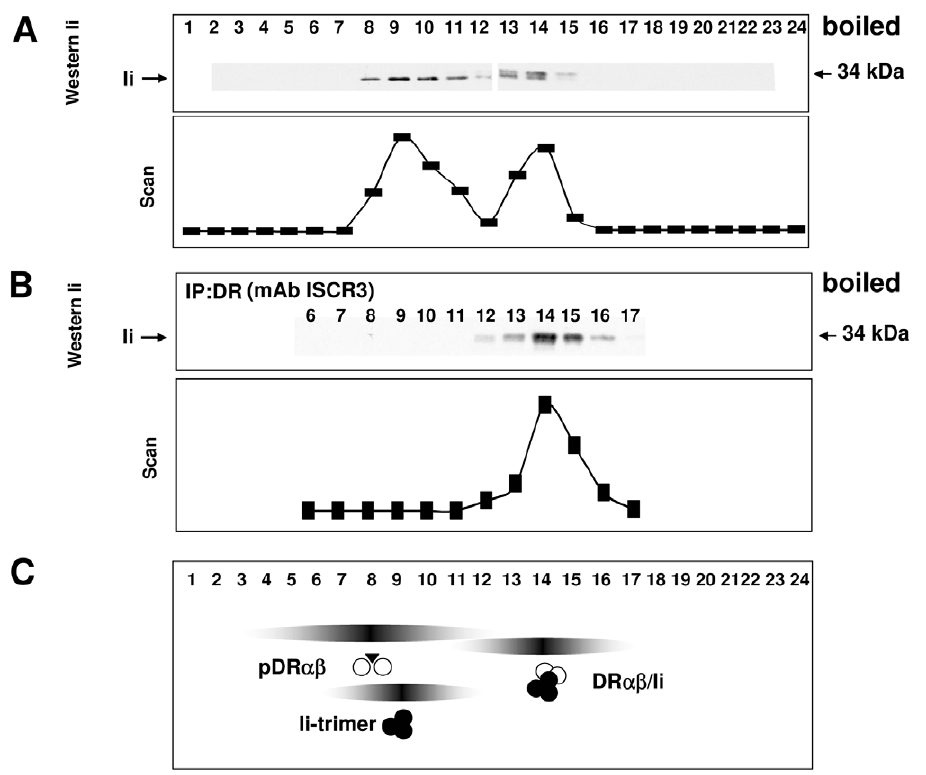
Figure 3. Detection of Ii in sucrose gradient fractions and delineation of DR and Ii complexes. A) SDS-PAGE separated Raji cell extracts from fractions 1 to 24 and western blotting for Ii (monoclonal antibody Bu43) (upper panel) results in two peaks (scan lower panel). B) Immunoprecipitation of DR, and SDS-PAGE separation was conducted as in Fig. 2C, followed by immunoblotting for Ii (monoclonal antibody Bu43, upper panel) and evaluation as a scan (lower panel). The DR-associated Ii appears in lanes 12 to 16. C) DR and Ii oligomers displayed in a sceme. Peptide-loaded DR (pDR ab ) largely co-migrates in the sucrose gradient with the Ii trimer. Complexes containing DR-Ii are separated in fractions 12 to 16.